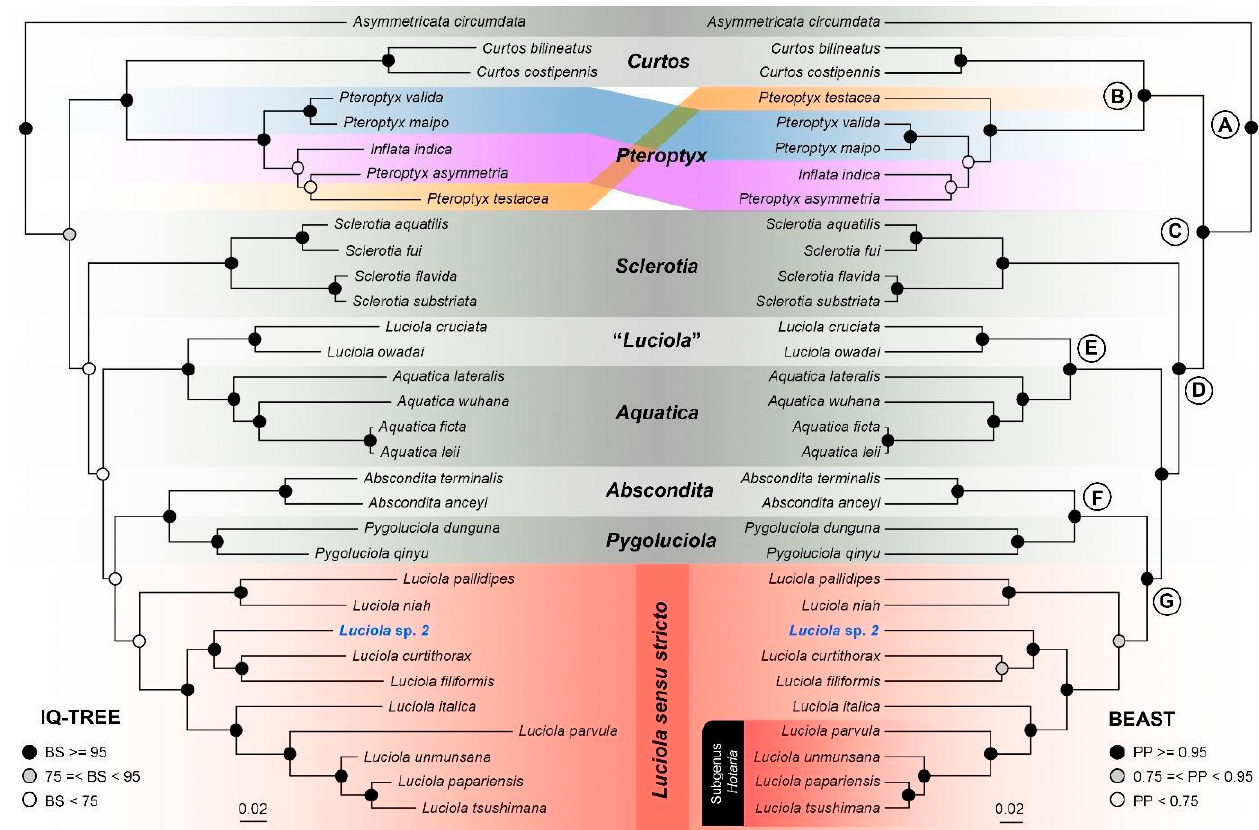
Figure 3. Maximum likelihood (left) and Bayesian (right) phylogenies based on 13,602 bps of mitogenomic data.